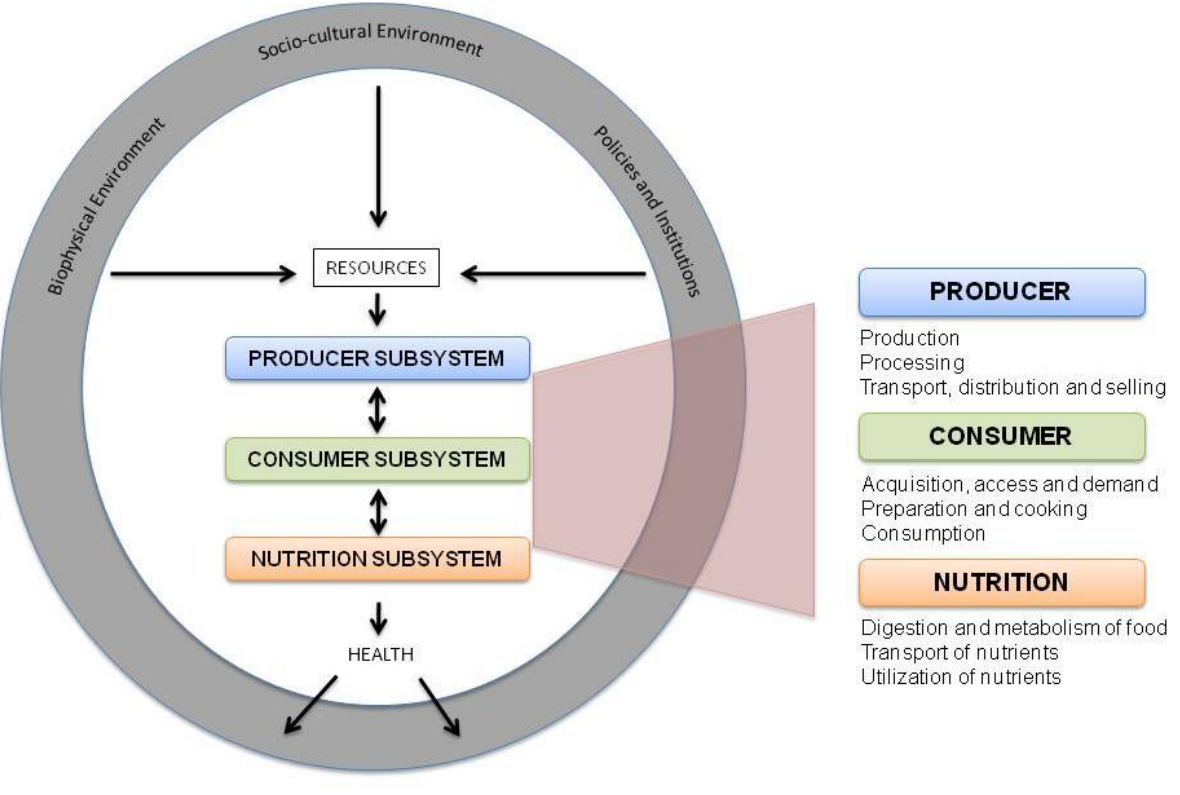
Figure 2. An integrated food and nutrition system (adapted from